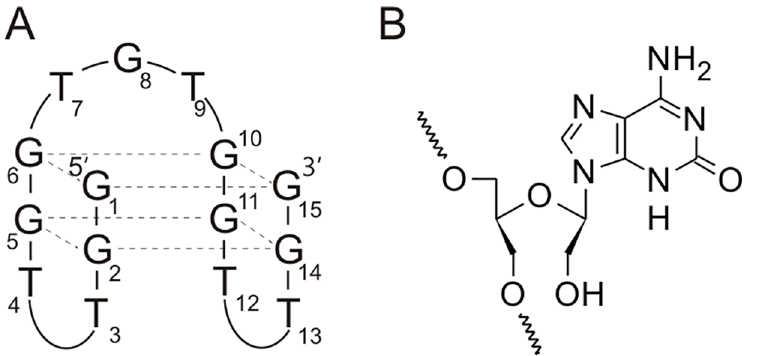
Fig 1. Structure of thrombin binding aptamer (A) and novel isoguanine derivative of UNA